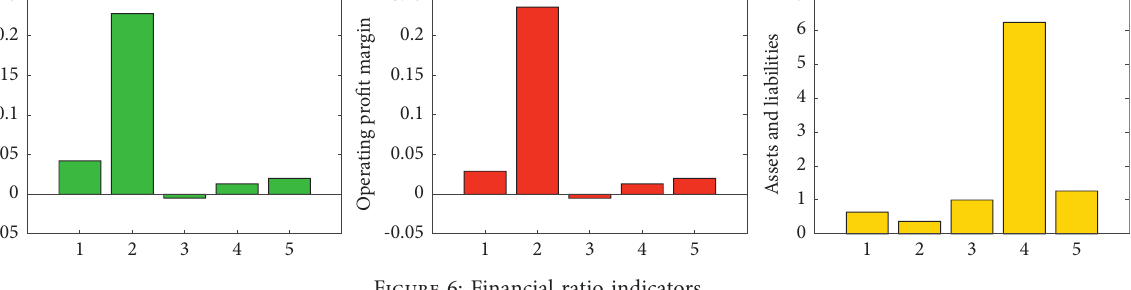
Figure 6: Financial ratio indicators.